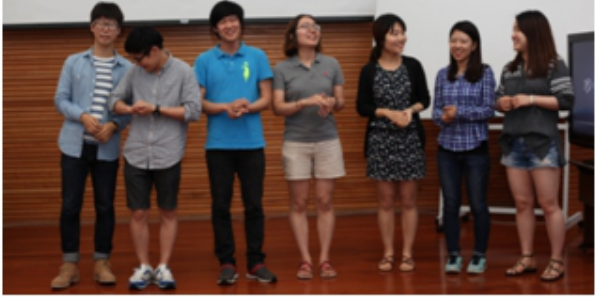
Figure 9. E4SD: A spontaneous expression of emotions